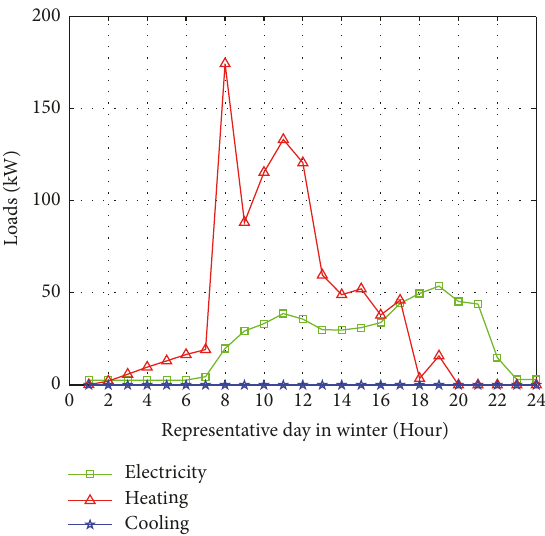
Figure 6: Hourly energy requirements in a winter day.